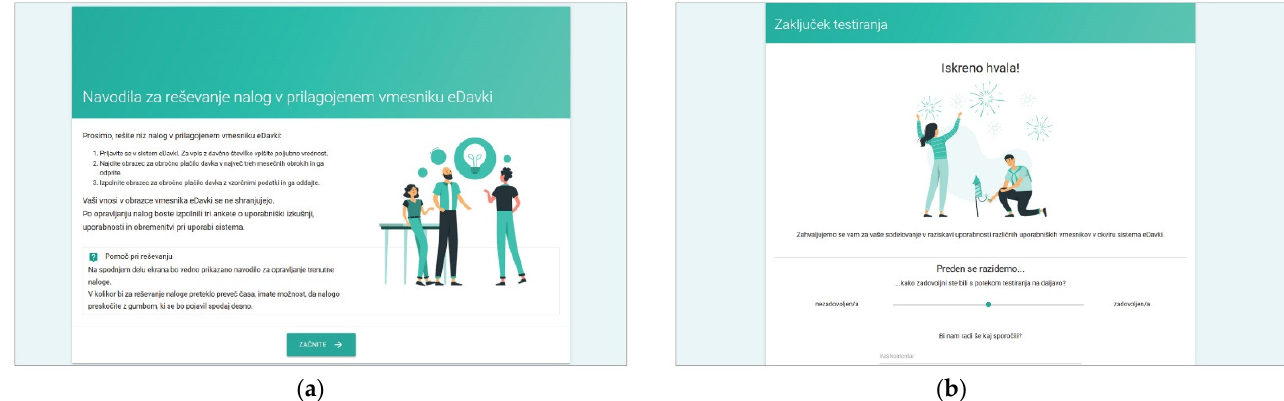
Figure 3. Testing platform interface displaying ( a ) the users’ task instructions and ( b ) the final “thank you” screen.